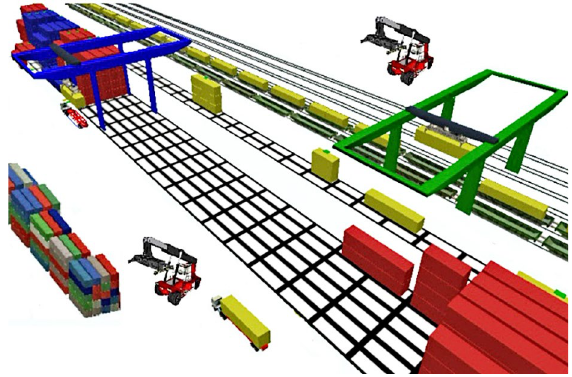
Fig. 2. Modified horizontal type of handling space layout Fig. 3. Vertical type of handling space layout